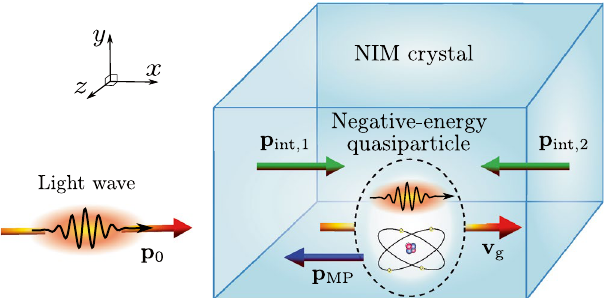
Figure 1. Schematic illustration of the coupled state of light in a NIM crystal exhibiting negative radiation pressure. The optical field is incident from the left. Inside the NIM crystal, it forms a coupled quasiparticle state with atomic displacements driven by the optical force density. When the field enters or exits the NIM crystal, the interfaces of the crystal take recoil momenta due to the momentum change of the EM wave in vacuum and the coupled state in the NIM crystal. In contrast to normal materials, the energy of the coupled state is negative, and its momentum is directed backward. The directions of the interface momenta are also reversed from what is observed for normal